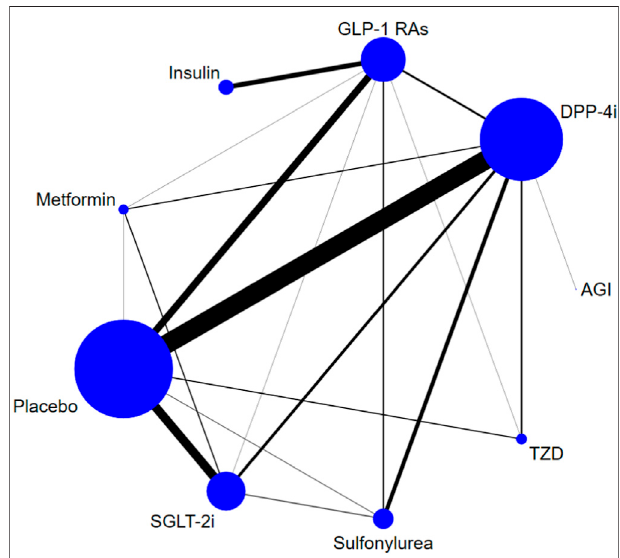
FIGURE 2 | Evidence structure of DPP-4i – , GLP-1 RA – , and SGLT- 2i – based therapies on risk of fracture. Note: The numbers along the link lines indicate the number of trials or pairs of trial arms. Lines connect the interventions that have been studied in head-to-head (direct) comparisons in the eligible randomized controlled trials. The width of the lines represents the cumulative number of randomized controlled trials for each pairwise comparison,and the sizeofeverynode isproportionalto thenumber of randomized participants (sample size). DPP-4i: dipeptidyl peptidase-4 inhibitors; GLP-1 RAs: glucagon-like peptide-1 receptor agonists; TZD: thiazolidinedione; AGI: alpha-glucosidase inhibitor; SGLT-2i: sodium-glucose cotransporter-2